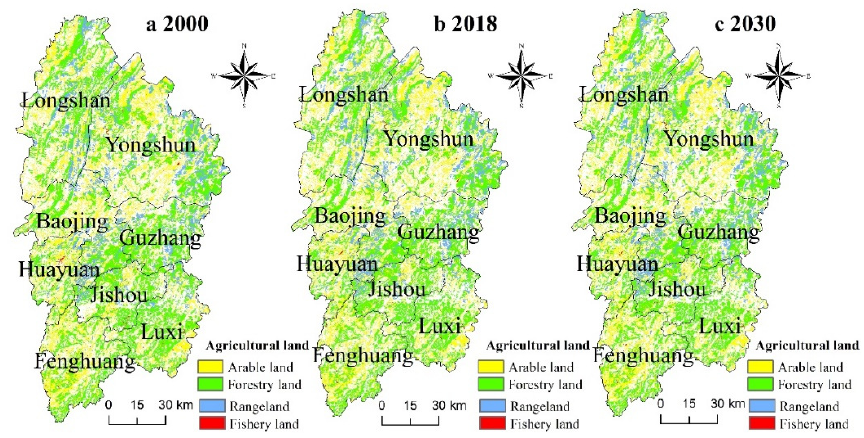
Figure 6. ( a – c ) Spatial pattern of agricultural land use in Xiangxi from 2000 to 2030. All types of agricultural land will decrease in 2030, and the extent of arable land has the highest loss of 113.47 km 2 as opposed to 2000, while fishery land has the lowest of 15.34 km 2 (Table 6). However, fishery land will have the highest negative loss rate ( − 49.78%), and rangeland the lowest negative loss rate ( − 1.86%). The above data shows that agricultural land change is mainly composed of arable land and fishery land. The reason is that the area where arable land and fishery land are located is more flat, with a larger number of population, which is more susceptible to interference by human activities. However, the composition of agricultural land was almost unchanged: forestry land had the largest proportion (49.97%), followed by arable land and rangeland (35.03% and 14.81%, respectively), and fishery land the smallest (0.19%). Overall, both of the area and proportion of agricultural land will decline in 2030, with a loss of 241.34 km 2 or 2.85% decrease from 2000. Table 6. Statistics of agricultural land in Xiangxi in 2030. Agricultural